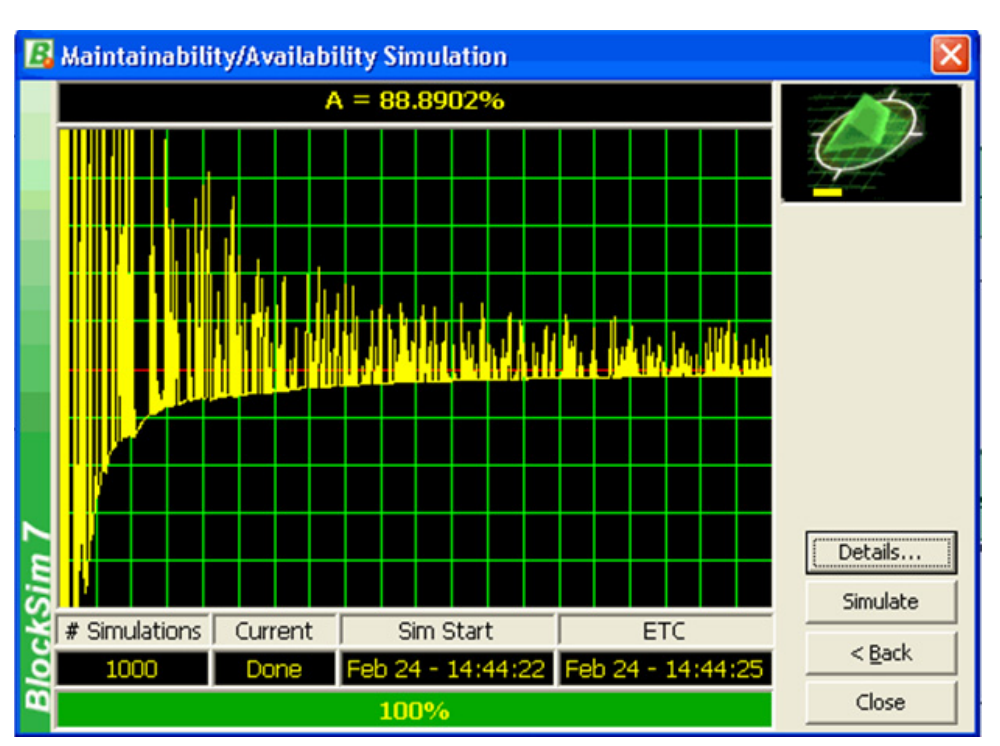
Figure 8. Availability